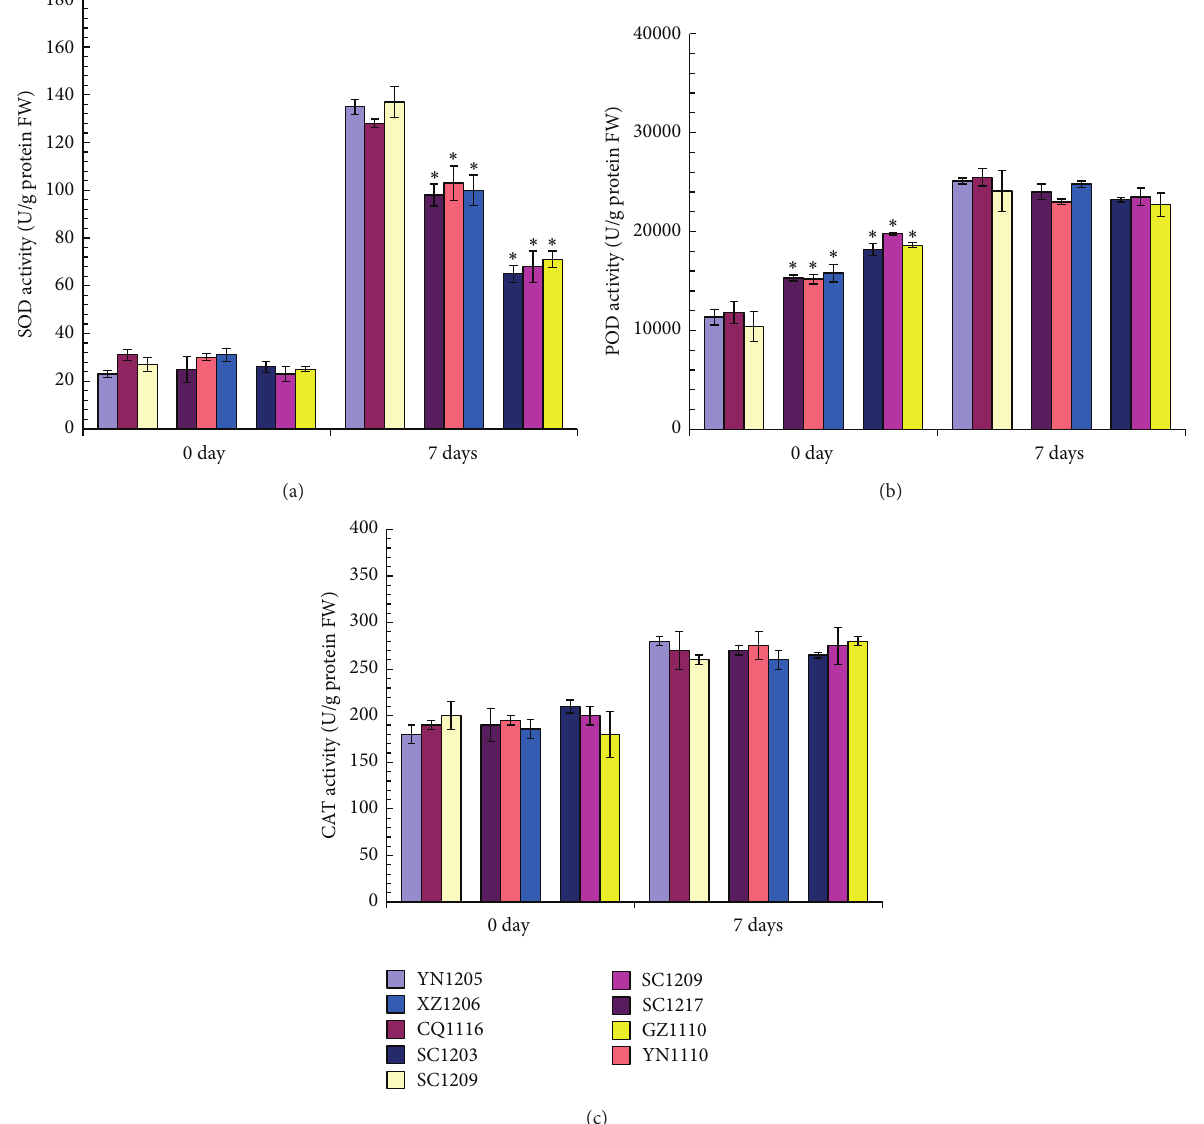
Figure 6: Comparison of antioxidant enzyme activities in leaves from C. dactylon accessions in response to SO 2 stress. Antioxidant enzyme activities of SOD (a), POD (b), and CAT (c) in leaves from nine selected C. dactylon accessions in response to SO 2 stress were compared. Mean values are presented with vertical error bars representing the standard deviations ( 𝑛 = 3 ). The asterisk symbols indicate significant differences between SO 2 -sensitive accessions and SO 2 -tolerant